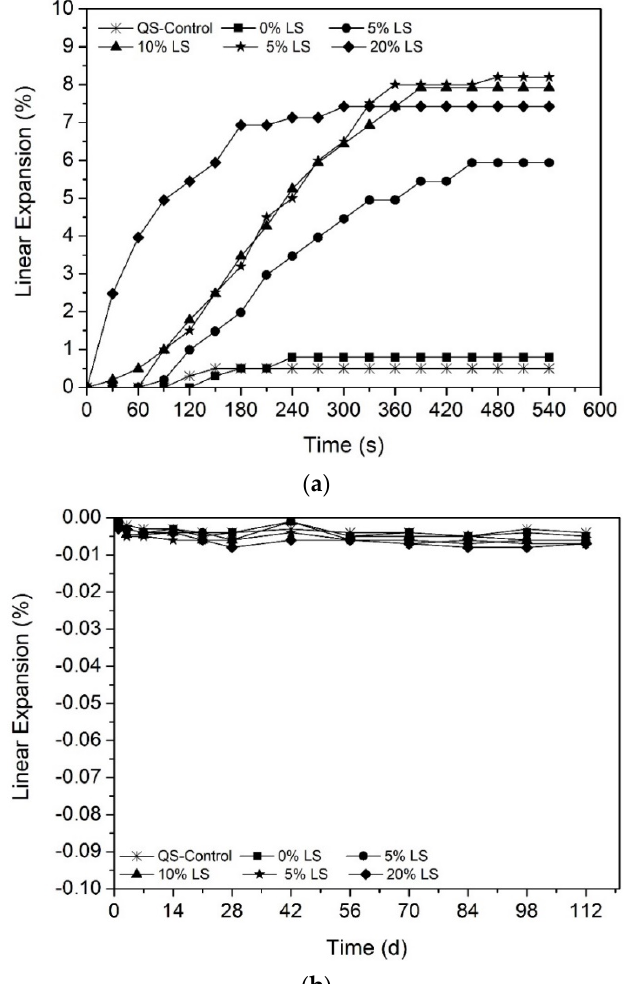
Figure 4. Linear expansion of MAPC mortar samples ( a ) before setting and ( b ) after setting; where the QS-Control refers to the sample prepared by quartz sand and 0 to 20% LS refers to samples prepared by limestone sand containing different contents of limestone fines ranging from 0 to 20% by weight of MAPC cement.